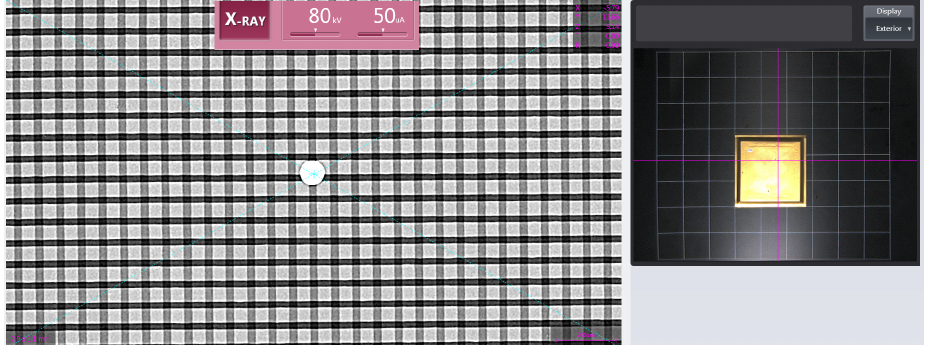
Figure 24: X-ray based two-dimensional (2D) optical inspection of cover with 200 µ m